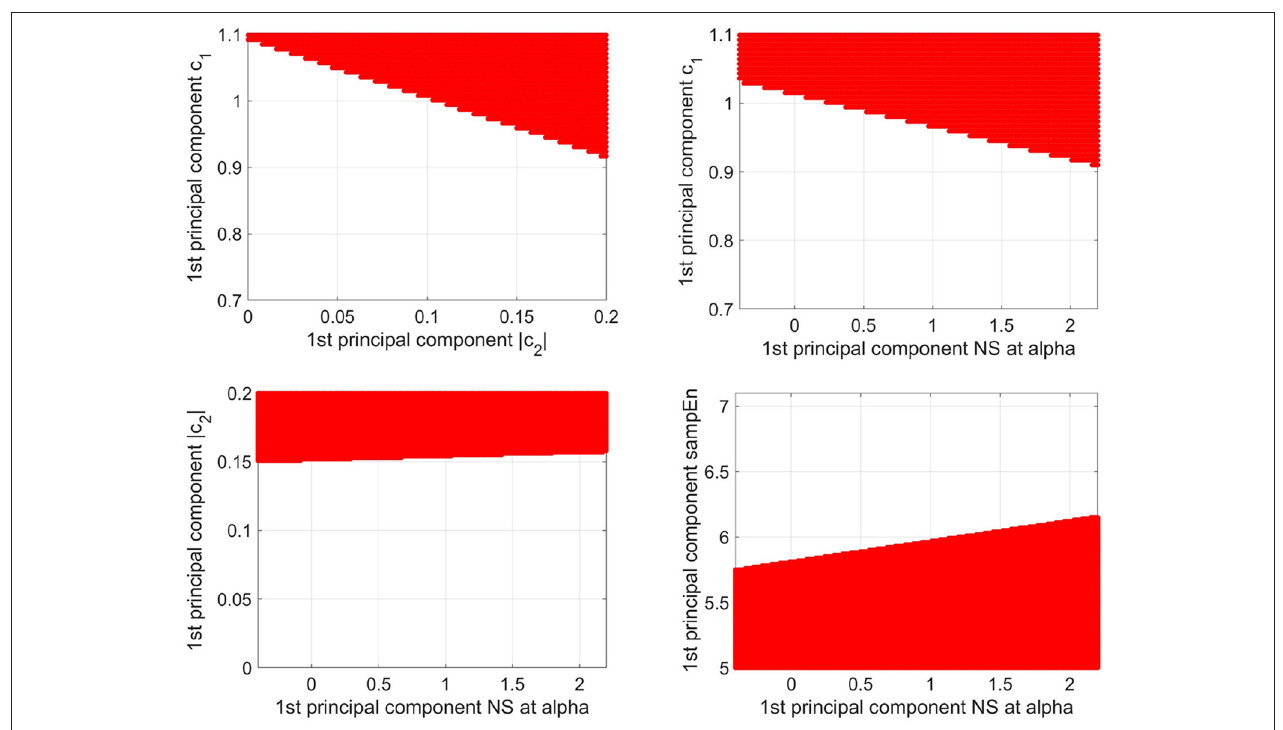
FIGURE 8 | Decision region (represented as the red region) for older participants with a decision probability of more than 0.9, obtained via logistic regression, is shown on the plane between the 1st principal component of c 1 and the 1st principal component of | c 2 | (upper left part), the plane between the 1st principal component of c 1 and the 1st principal component of NS at alpha (upper right part), and the plane between the 1st principal component of | c 2 | and the 1st principal component of NS at alpha (lower left part), and the plane between the 1st principal component of sample entropy and the 1st principal component of the NS at alpha (lower right part). Here, the other components, except for the axis of the planes, were set to average among participants in both the younger and older groups. The dependency on all these factors in the decision region was confirmed.